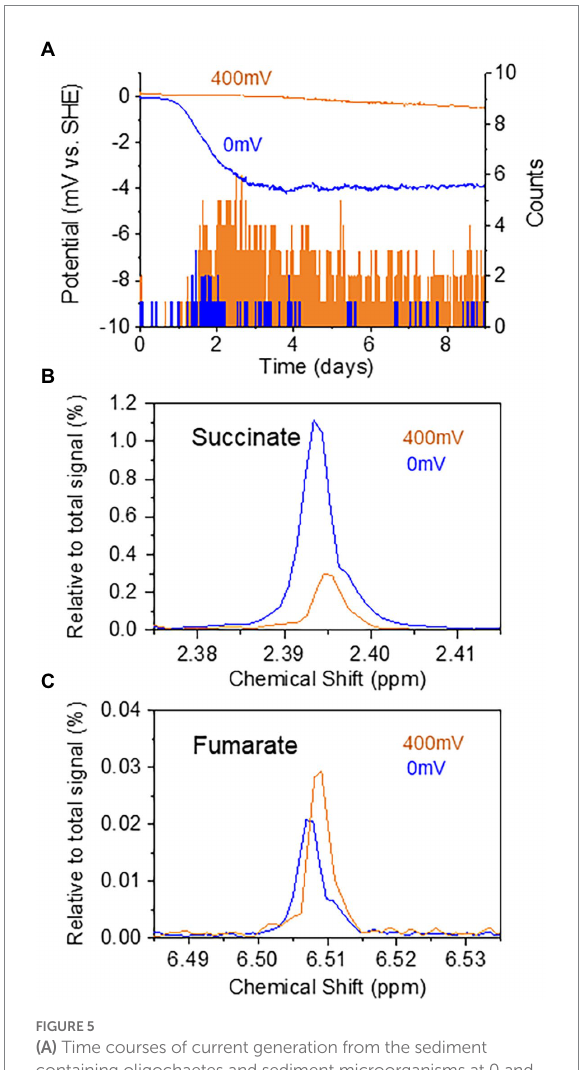
FIGURE 5 (A) Time courses of current generation from the sediment containing oligochaetes and sediment microorganisms at 0 and 400 mV. The number of oligochaetes with tails protruding from the sediment into the sea water at 0 and 400 mV is indicated by orange and blue bars, respectively. (B,C) Potential-dependent changes in the relative intensity of the NMR signals for succinate (B) and fumarate (C)